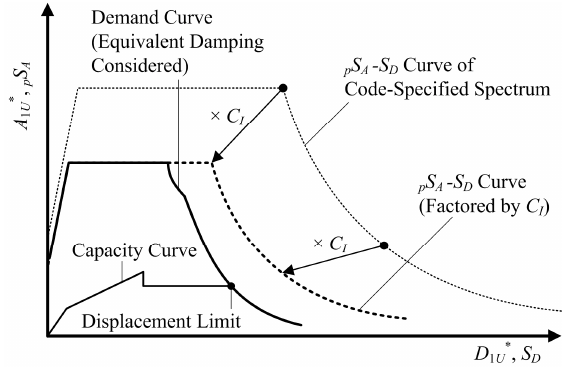
Figure 1. Definition of capacity index C I .